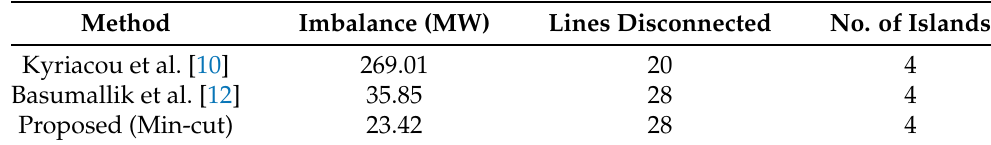
Table 4. Comparison of the proposed method with the literature on case